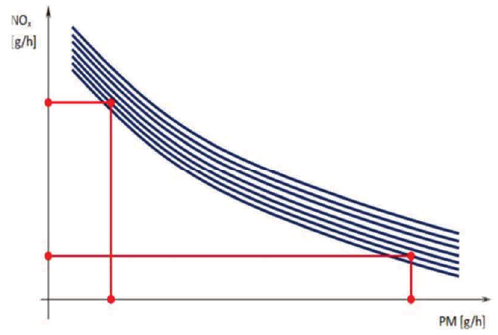
Fig. 19. The correlation between emission intensity of PM and emission intensity of nitrogen oxides emissions (NO x ) in diesel engine exhaust gases